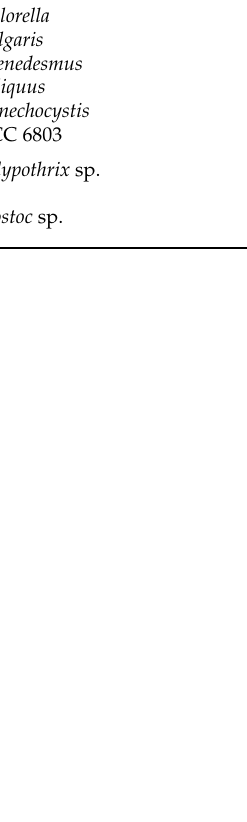
Table 2. Oil extraction